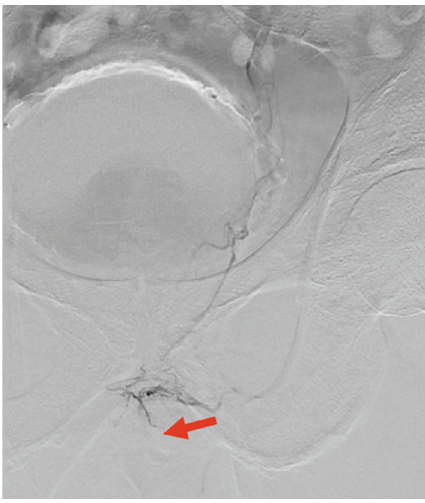
Figure 1: Presence of collateral vessels from the lateral prostatic artery to the penis and nontarget embolization of the penile artery (arrow).